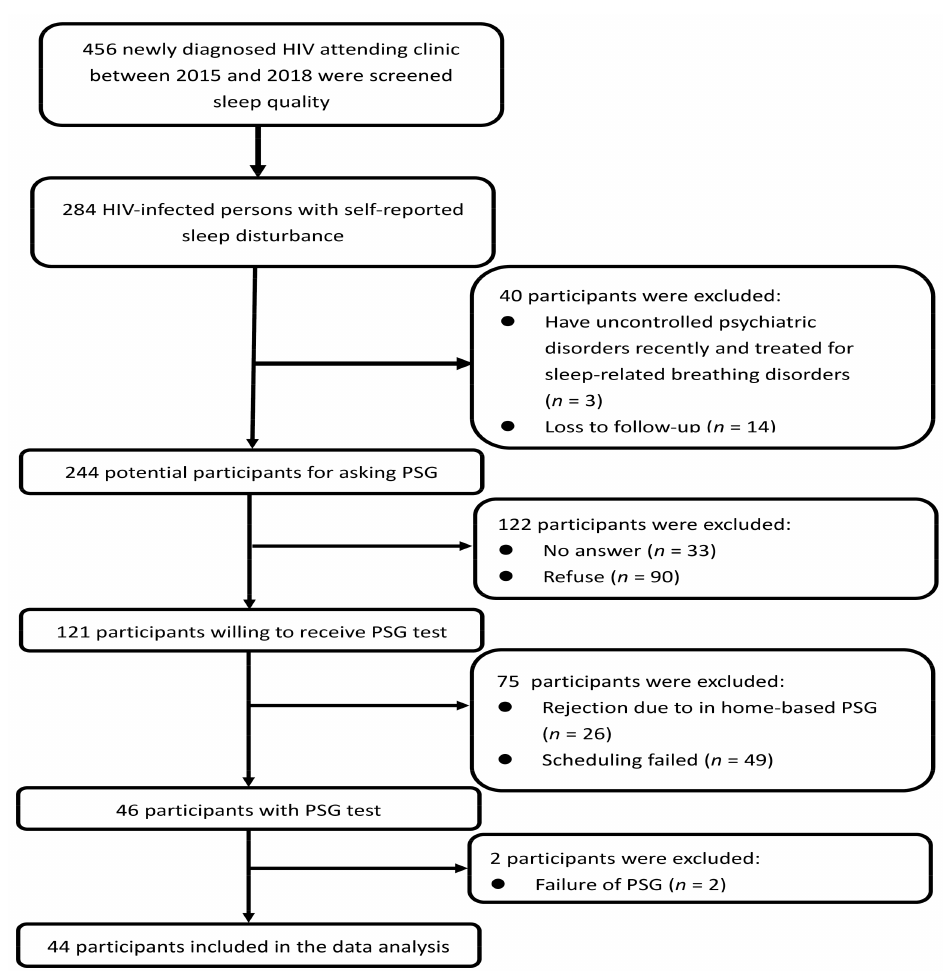
Figure 1. Flowchart of enrollment of HIV-infected persons for the polysomnography test.